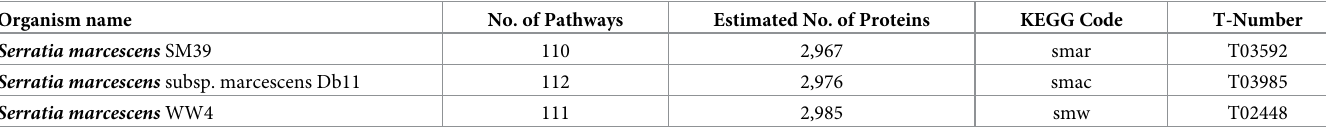
Table 1. Detailed information on different strains of S . marcescens used in current